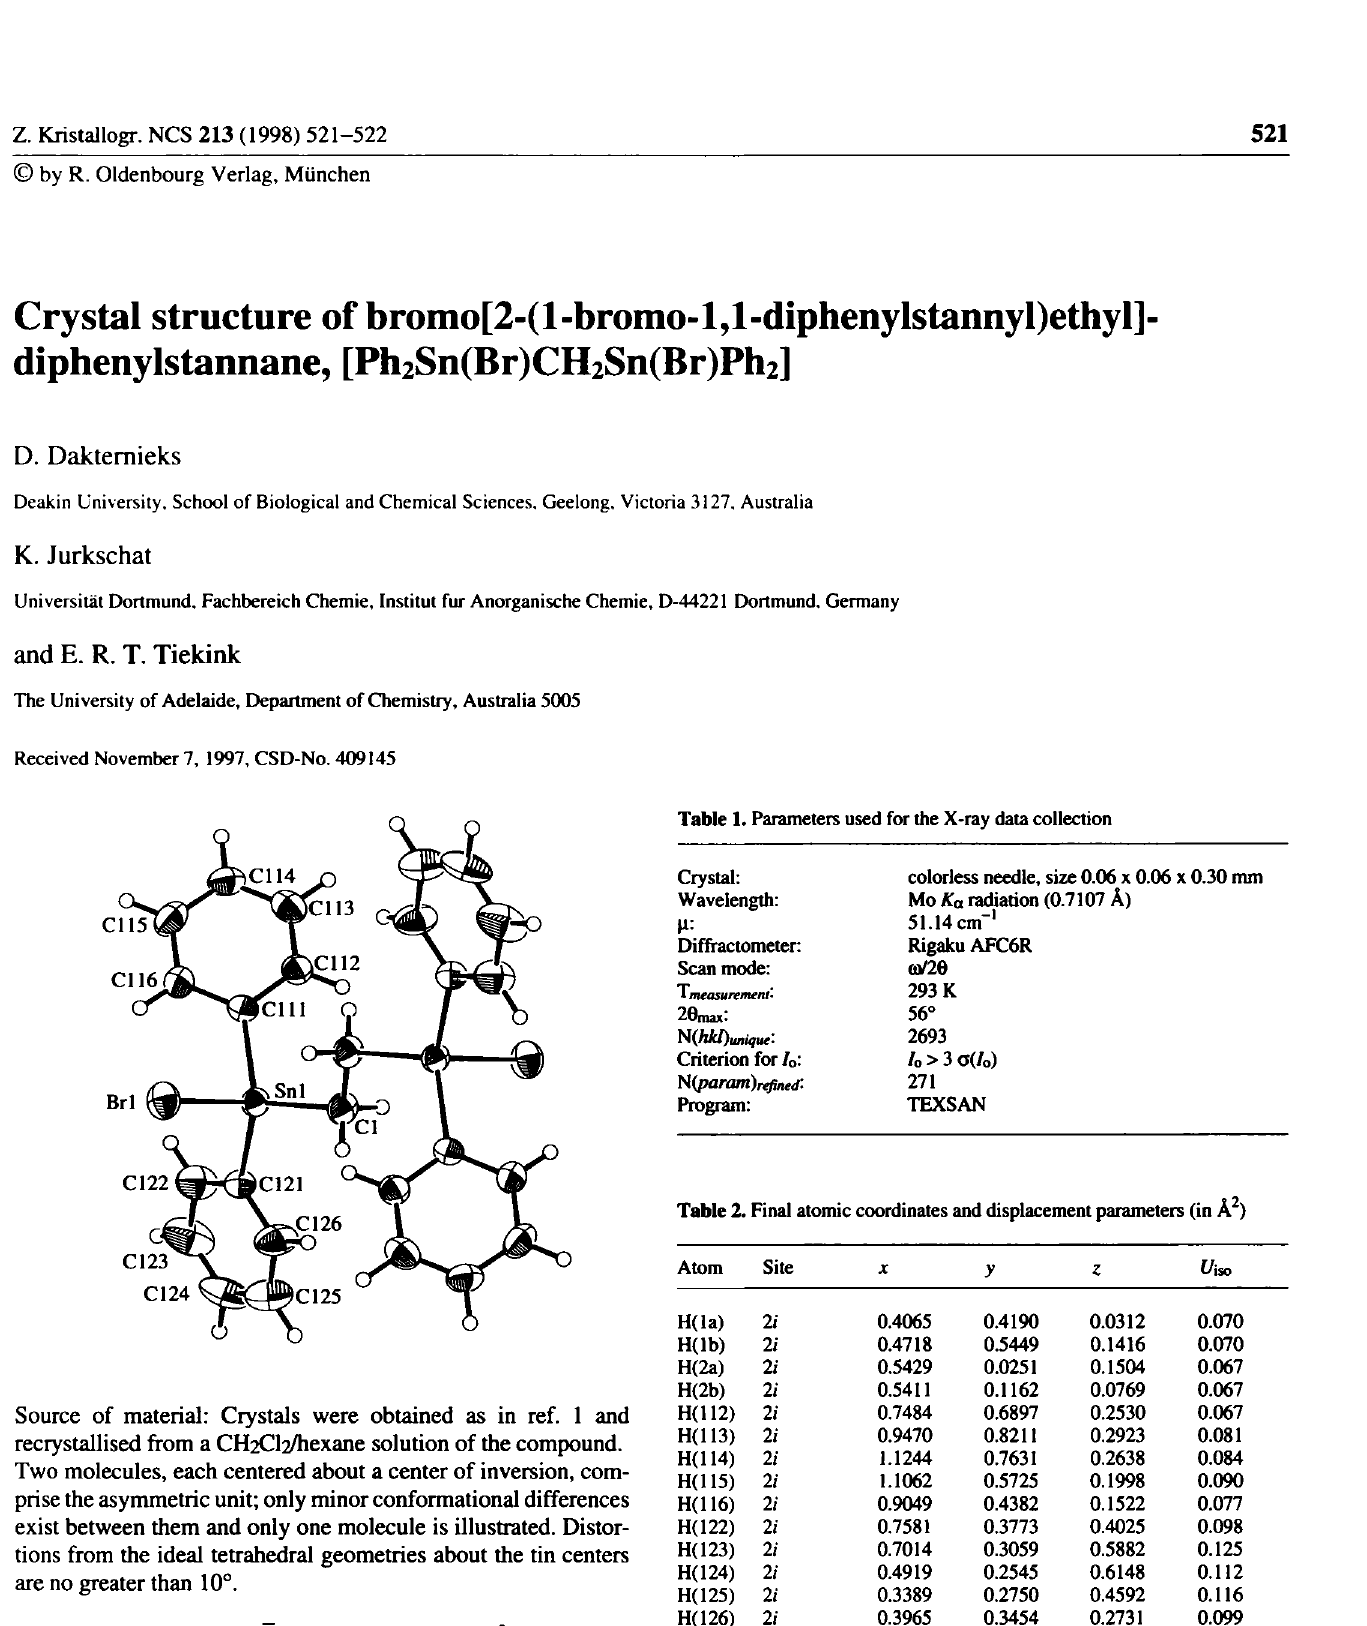
Table 2. Final atomic coordinates and displacement parameters (in Â^)